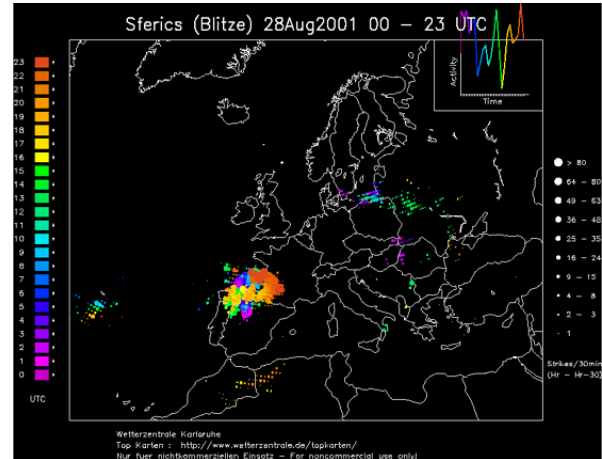
Fig. 5. Date: 28 August 2001, CL1. Spatial, temporal and intensity distribution of lightning events.